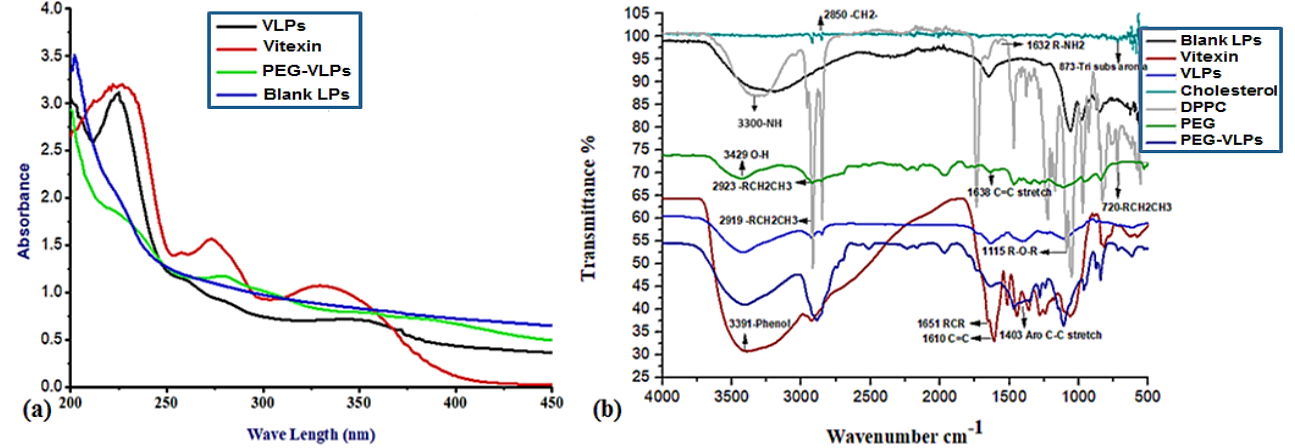
Figure 2. Comparative UV-Vis Spectra ( a ) and FTIR spectra ( b ) of Vitexin, Blank liposomes (LPs), Vitexin liposomes (VLPs), and polyethylene glycol coated vitexin liposomes (PEG-VLPs).